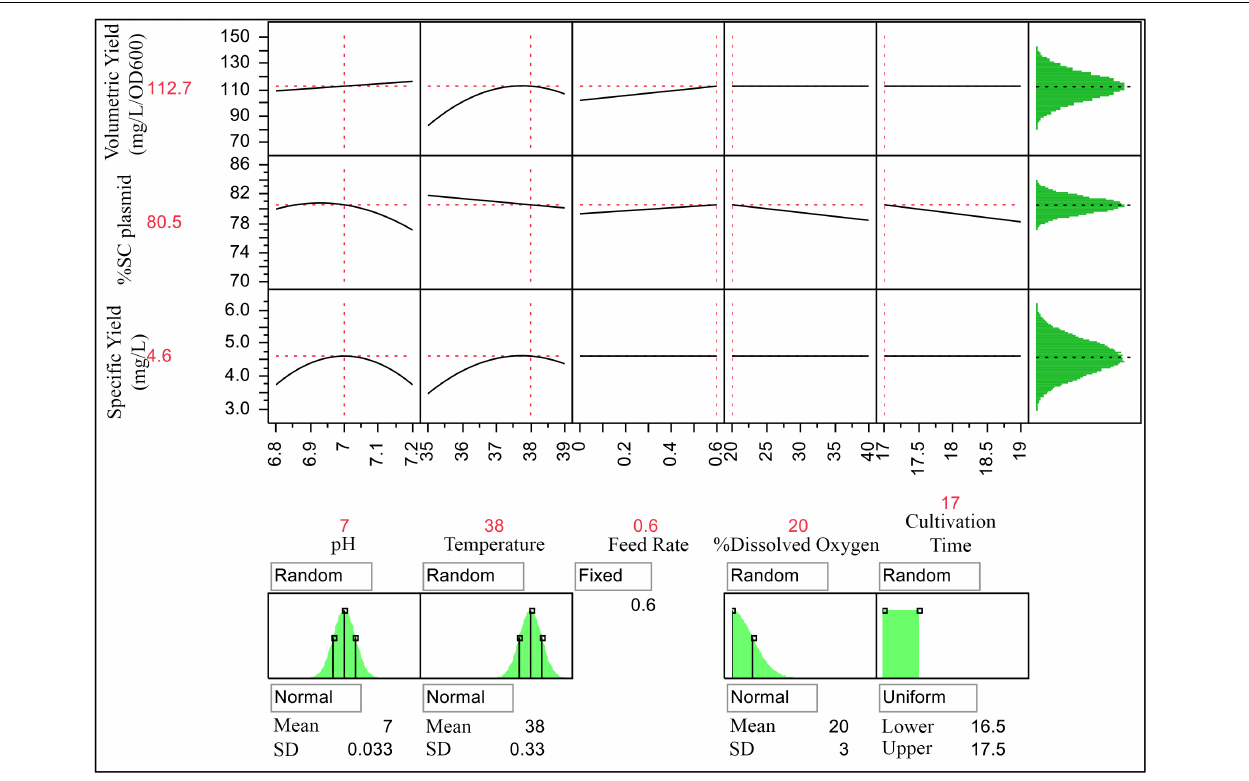
FIGURE 4 | Prediction profiler for process optimization and simulation studies with Monte Carlo simulations of 100,000 runs with different data distribution types (shown underneath their respective response curves).